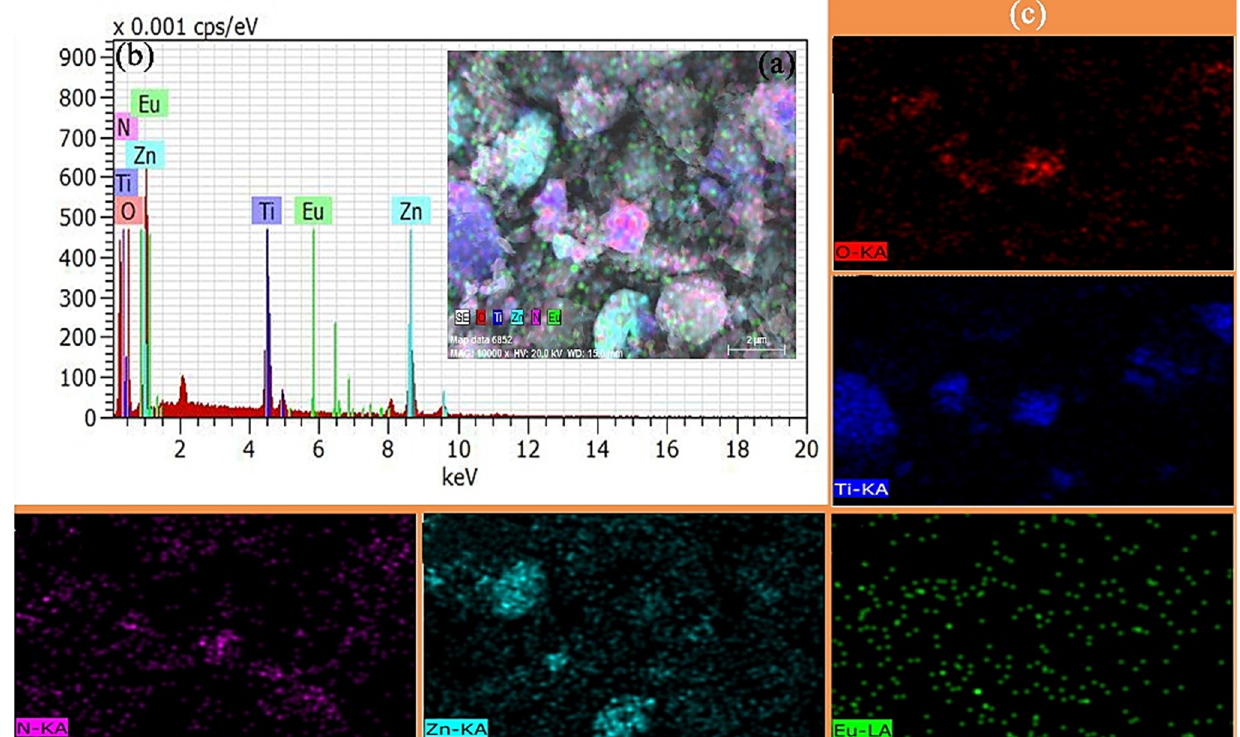
Figure 3. ( a , b ). ZIF-8(Eu)@Mc-TiO 2 EDX diagram and ( c ). single element EDX mapping of ZIF-8(Eu)@Mc-TiO 2. Figure 3. ( a , b ) ZIF-8(Eu)@Mc-TiO 2 EDX diagram and ( c ) single element EDX mapping of ZIF-8(Eu)@Mc-TiO 2